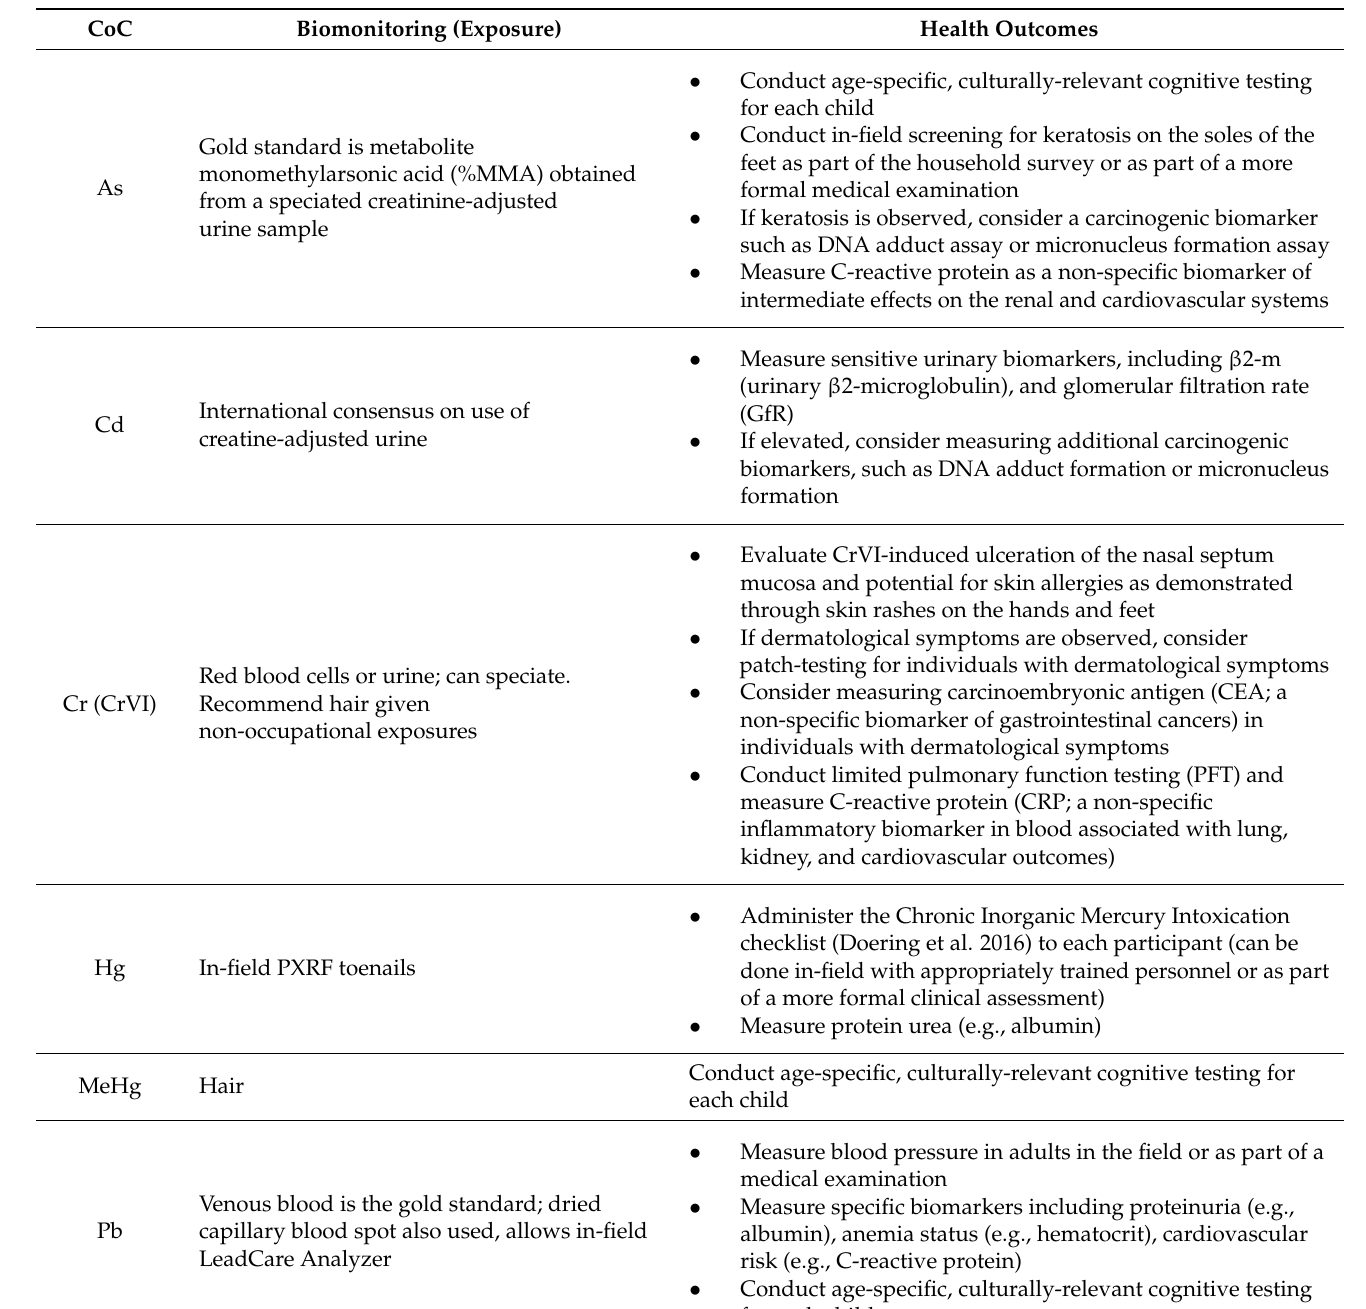
Table 3. Overview of activity-specific sampling guideline